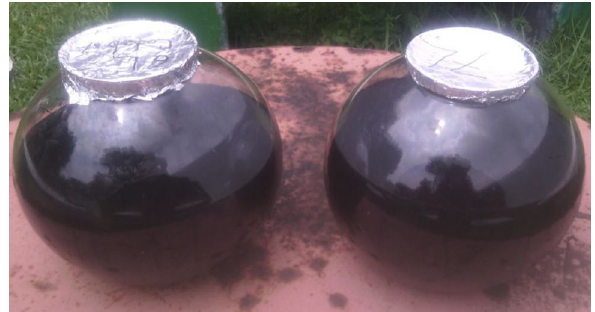
Fig. 2 Solar irradiation of textile wastewater samples in the presence of Fe 2 O 3 NPs for irrigating on